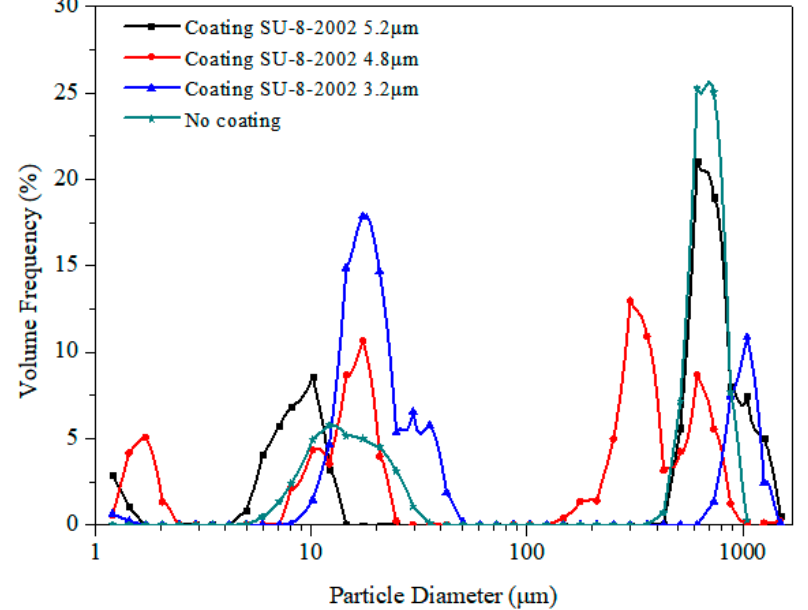
Figure 9. The volume-based droplet size distribution of atomization at 4.68 W with a 30 MHz excitation radio frequency (RF signal), measured with a laser diffraction analyzer.